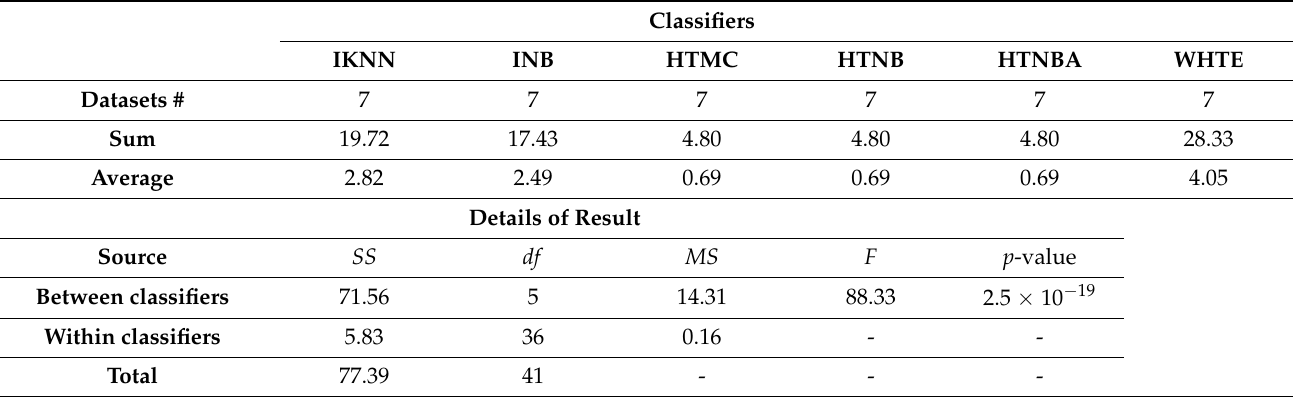
Table 6. The ANOVA test results, where memory usage is the independent